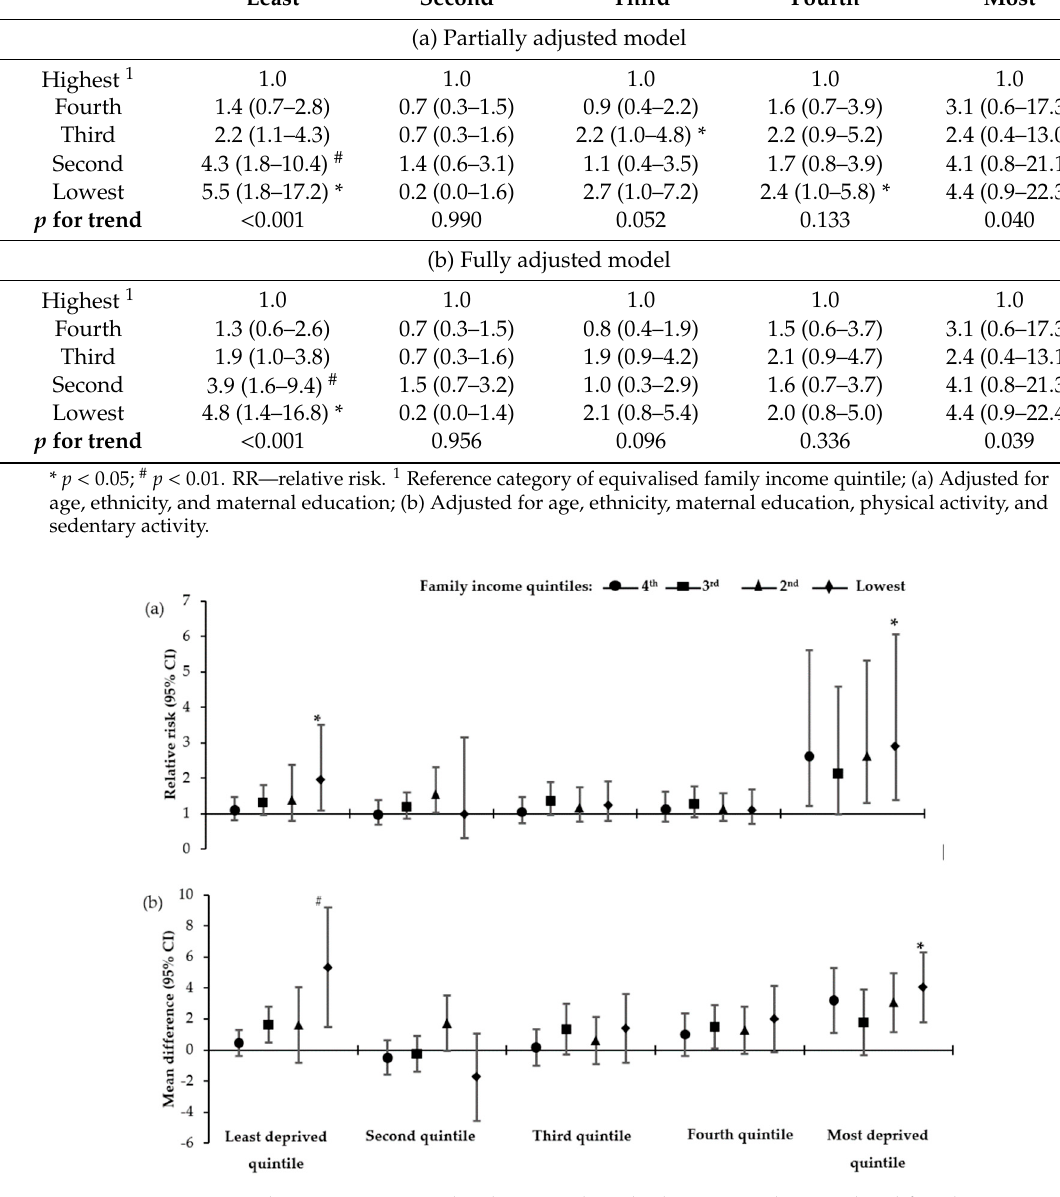
Figure 1. Association between overweight / obesity risk and adiposity and equivalised family income quintiles stratified by quintiles of geographic-level deprivation. ( a ) Relative risk (95% CI) of overweight / obesity by family income quintiles—model adjusted for sex, age, ethnicity, maternal education, physical activity, sedentary activity; ( b ) Mean di ff erence (95% CI) of percentage body fat by family income quintiles—model adjusted for sex, ethnicity, maternal education, physical activity, sedentary activity. Reference category is the highest family income quintile. * p for trend < 0.05; # p for trend < 0.01. Unless otherwise stated, p for trend for the model was >0.05.